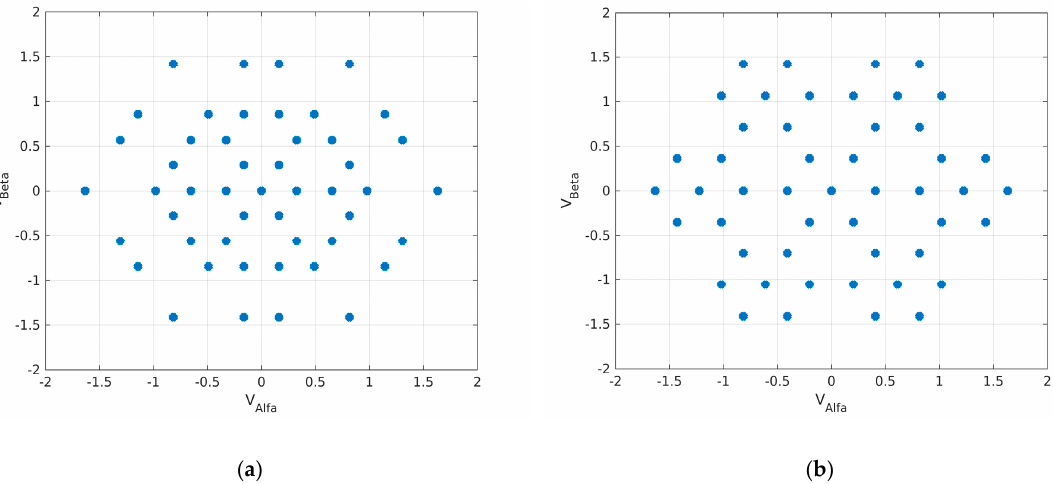
Figure 5. Vectors considering ( a ) V DC1 reduces to 80% of their nominal value and V DC 2 increases 20% ( b ) V DC 1 reduces to 50% of their nominal value and V DC 2 increases 50%, in pu. ( b ) V DC 1 reduces to 50% of their nominal value and V DC2 increases 50%, in pu.